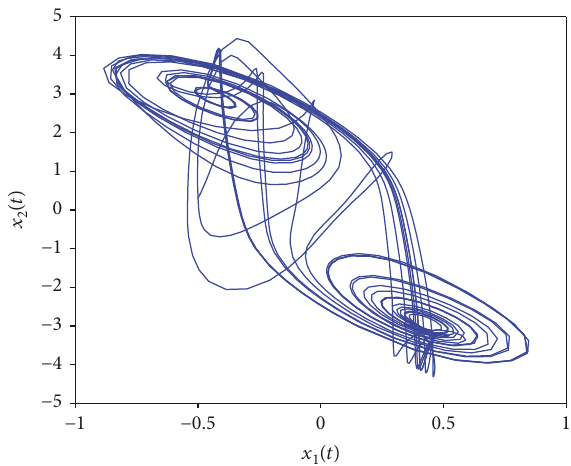
Figure 1: Attractor of neural network model [21]. Figure 2: Power spectral plot of neural network model